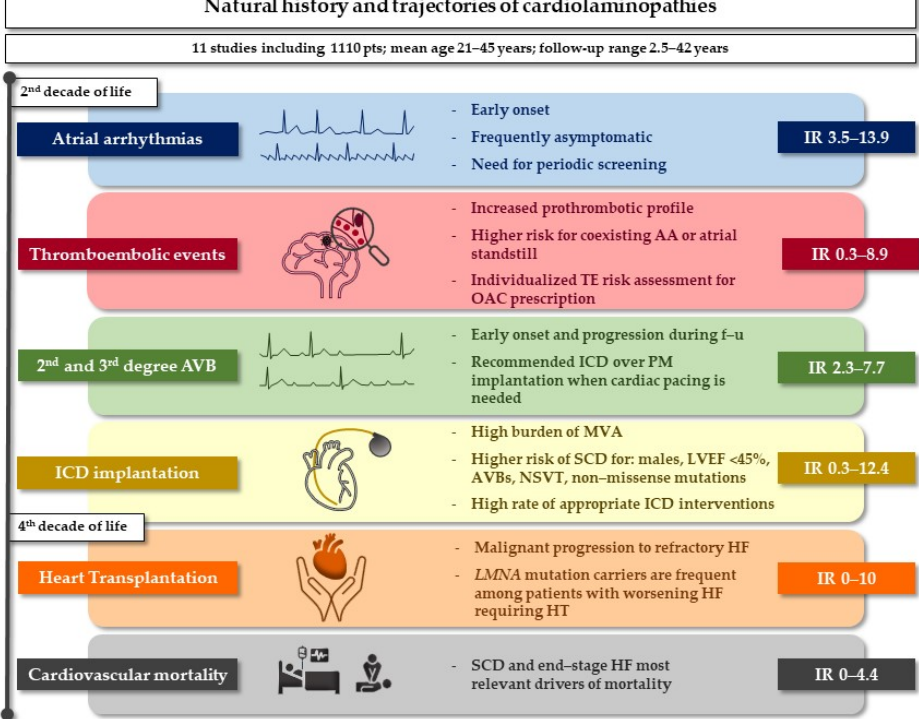
Figure 2. Natural history of cardiolaminopathies and main findings. Legend: AA, atrial arrhythmias; AVB, atrioventricular block; DCM, dilated cardiomyopathy; HF, heart failure; HT, heart transplantation; ICD, implantable cardioverter–defibrillator; IR, incidence rate; LVEF, left ventricular ejection fraction; MVA, malignant ventricular arrhythmias; NSVT, non-sustained ventricular tachycardia; OAC, oral anticoagulant; PM, pacemaker; SCD, sudden cardiac death.